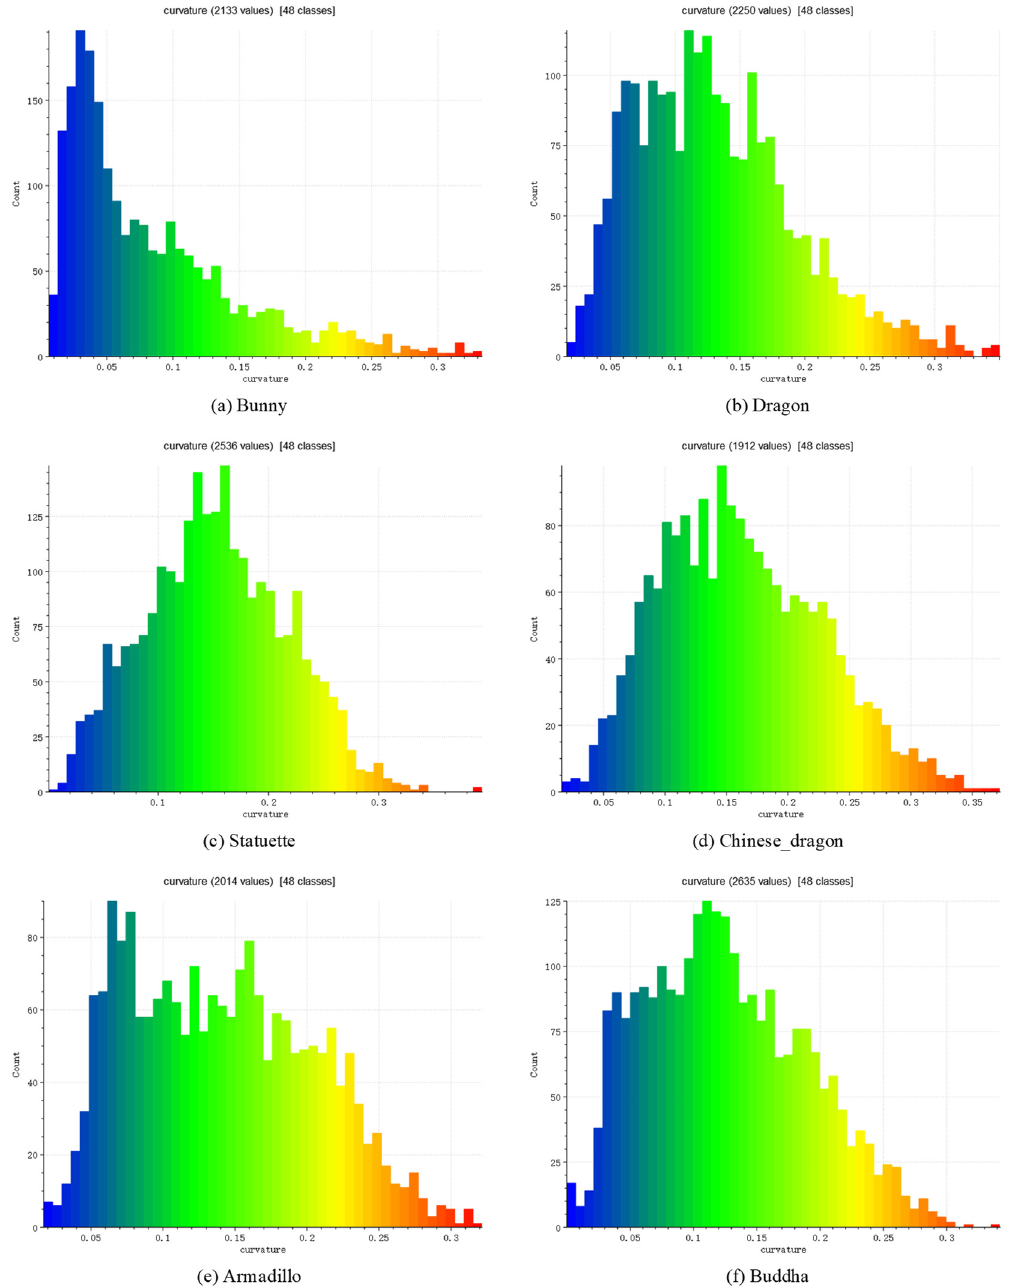
Figure 12. Curvature histograms of six models. The curvature of each model is divided into high/low part according to curvature histograms. ( a ) is the curvature histogram of Bunny model. Its high-curvature part is greater than 0.2 and the low-curvature part is 0–0.02; ( b ) is the curvature histogram of the Dragon model. Its high-curvature part is greater than 0.22 and the low-curvature part is 0–0.07; ( c ) is the curvature histogram of the Statuette model. Its high-curvature part is greater than 0.2 and the low-curvature part is 0–0.1; ( d ) is the curvature histogram of the Chinese_dragon model. Its high-curvature part is greater than 0.24 and the low-curvature part is 0–0.1; ( e ) is the curvature histogram of Armadillo model. Its high-curvature part is greater than 0.18 and the low-curvature part is 0–0.07; ( f ) is the curvature histogram of Buddha model. Its high-curvature part is greater than 0.18 and the low-curvature part is 0–0.07.